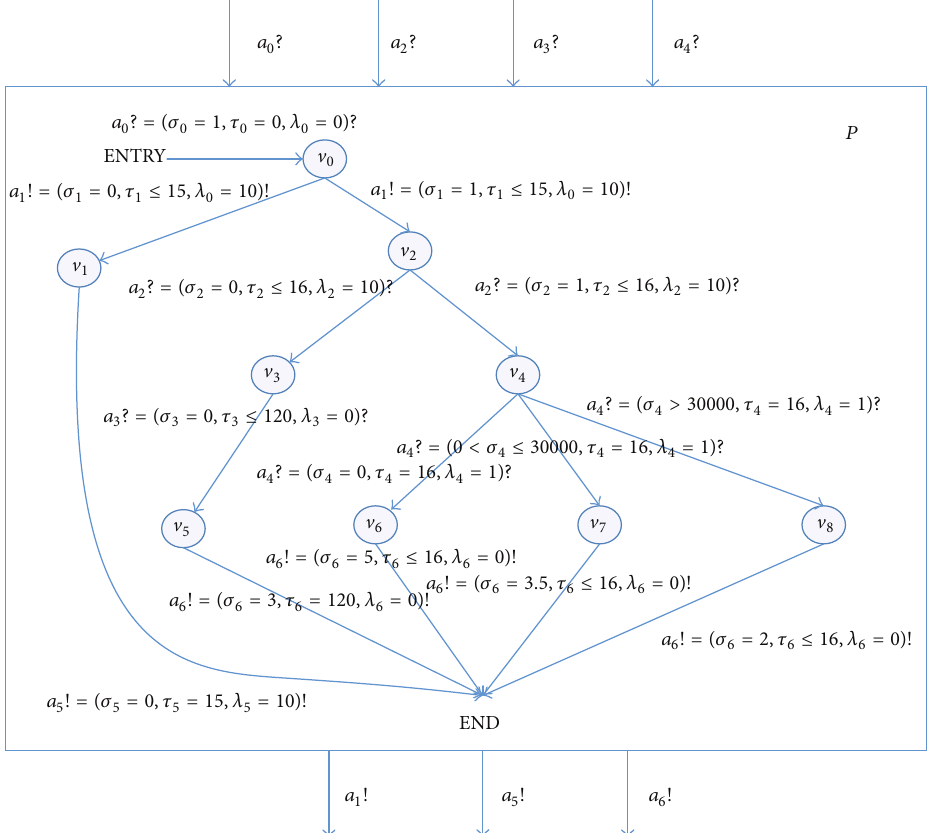
Figure 7: The aircraft braking system automata 𝑃 .